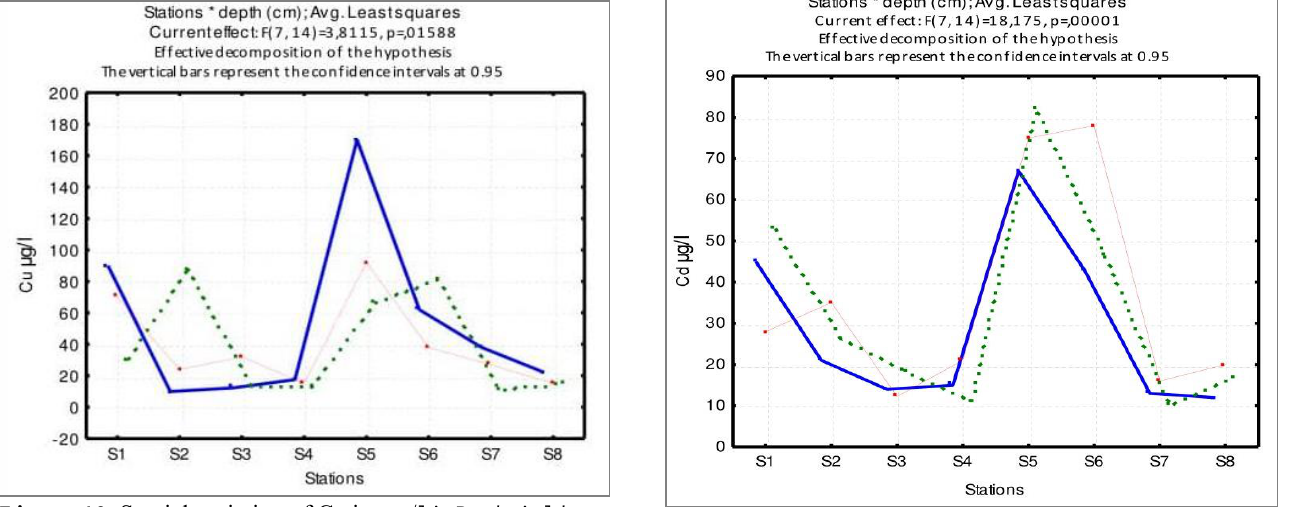
Figure 10. Spatial variation of Cu in μg /l in Reghaia lake. Figure 11 shows that the value of Nickel ranged from 0.027 to 0.04mg / L from upstream to the lake dike and between 40 to 10 μg / L from surface to depth.